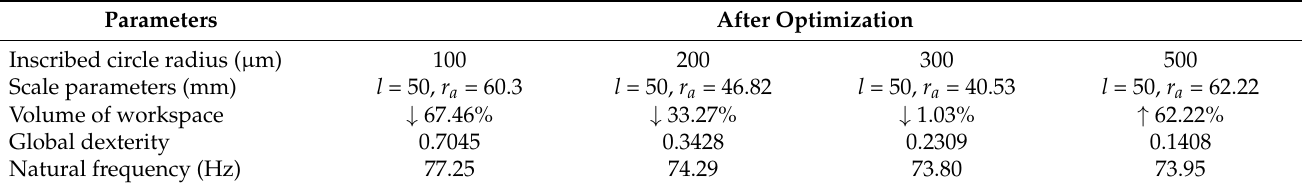
Table A1. Comparison of the scale parameters of micromanipulator, kinematic and dynamic perfor- mances before and after optimization with different inscribed circle